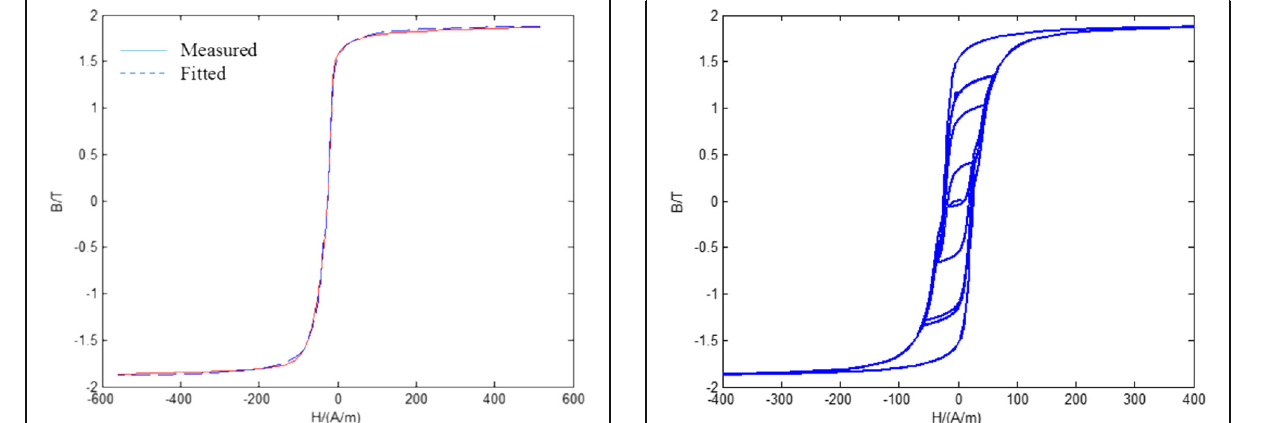
Fig. 6 Magnetization curve of closed-core CT model based on Preisach